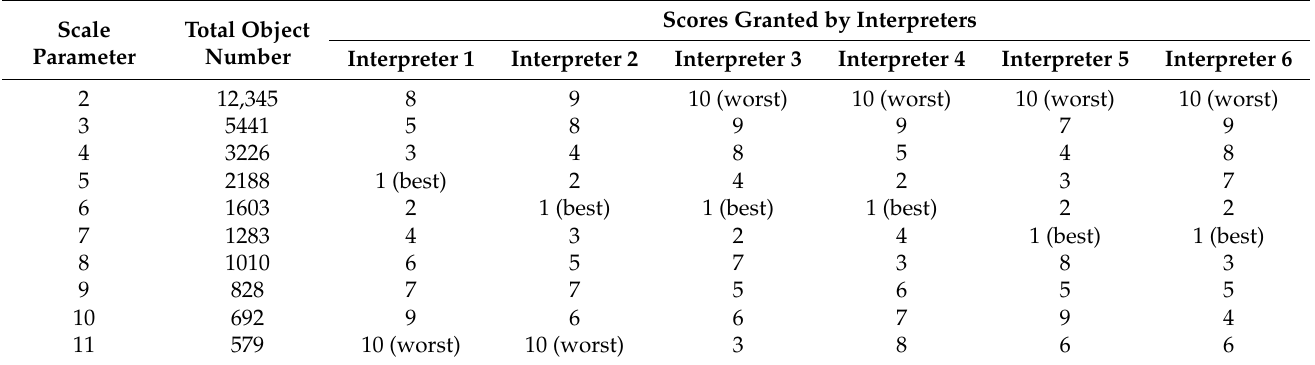
Table 2. Example of optimal segmentations determined through visual inspections for Almer í a study site, winter season, and S2 Percent orthoimage. Note that the corresponding scale parameter remained hidden from the interpreters during visual